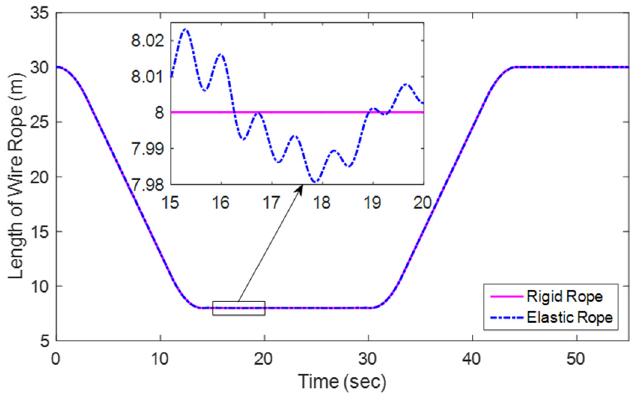
Fig. 7. Length variation curves of the wire rope.